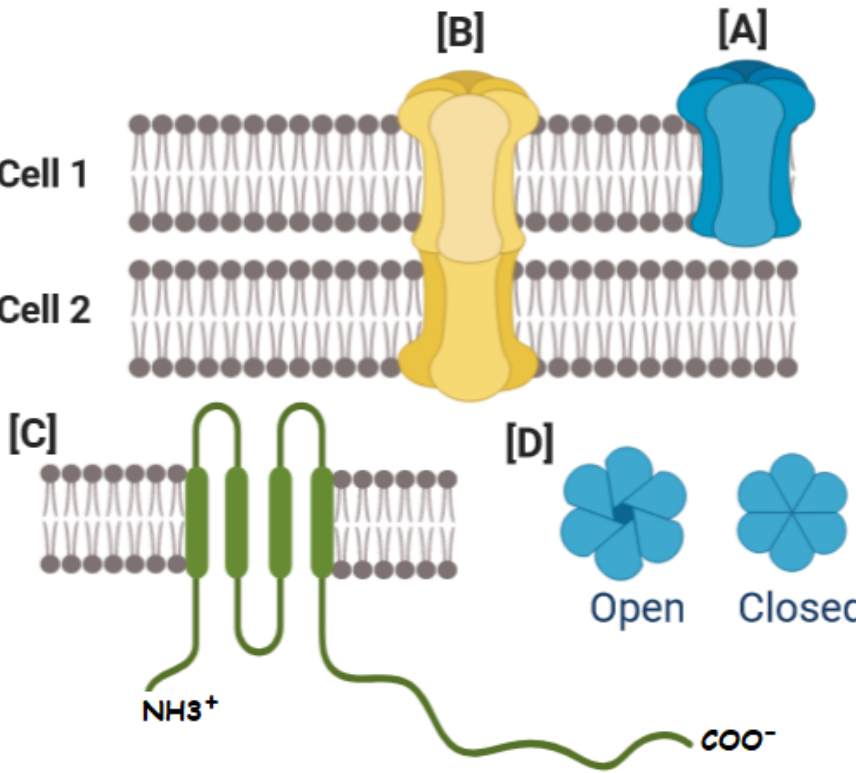
Figure 1. Connexins (Cxs), and connexin-based channels. ( A ) The oligomerization of six Cxs creates a hexamer named connexon or HC. ( B ) HCs interacting with opposing HCs from neighboring cells can dock to form different types of GJCs. ( C ) Cxs have cytosolic amino-terminal and carboxy-terminal ends, one cytoplasmic loop (CL), four transmembrane domains called M1, M2, M3 and M4, and two extracellular loop domains. ( D ) The size and charge of the aqueous pore formed by Cxs determine channel conductance and selectivity, allowing the cell to regulate various cellular processes, including the transport of molecules between connected cells. The gating of GJC indicated by the open-closed transition is modulated by a variety of factors, including voltage, H(+), Ca(2+), and phosphorylation.